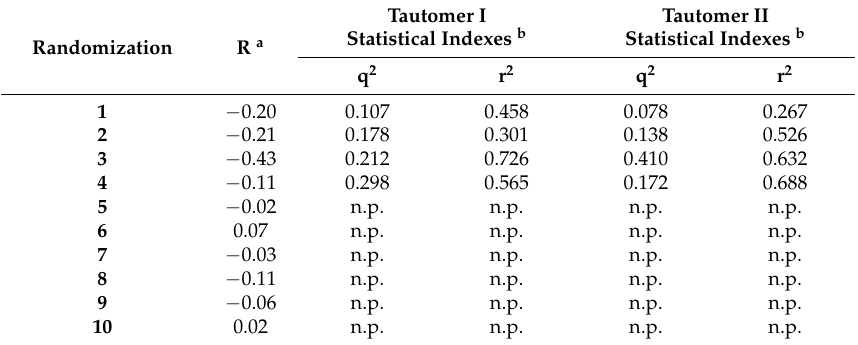
Table 5. Values of R, q 2 , and r 2 of ten HQSAR runs generated for each randomized dataset (tautomers I and II, N = 32) using the Y-randomization